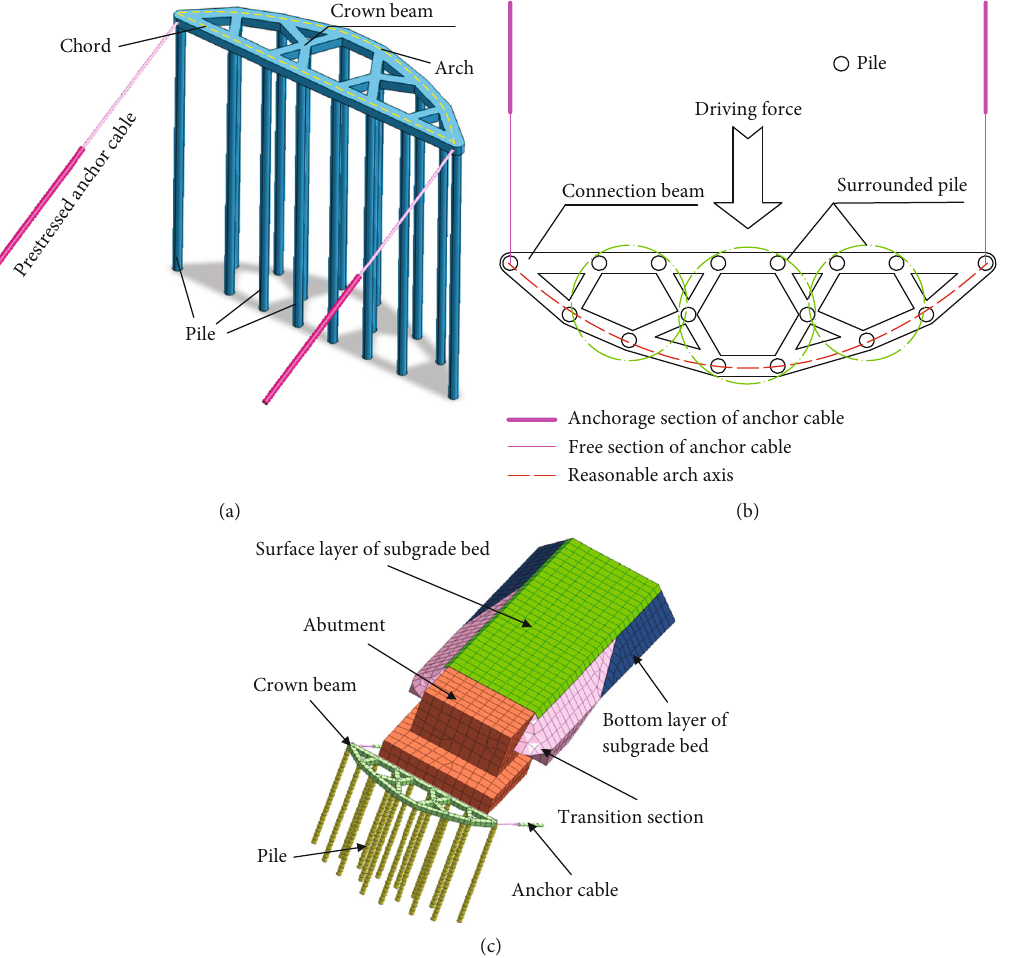
Figure 1: An arch-chord-coupled antisliding structure: (a) spatial shape; (b) top view; (c) typical application